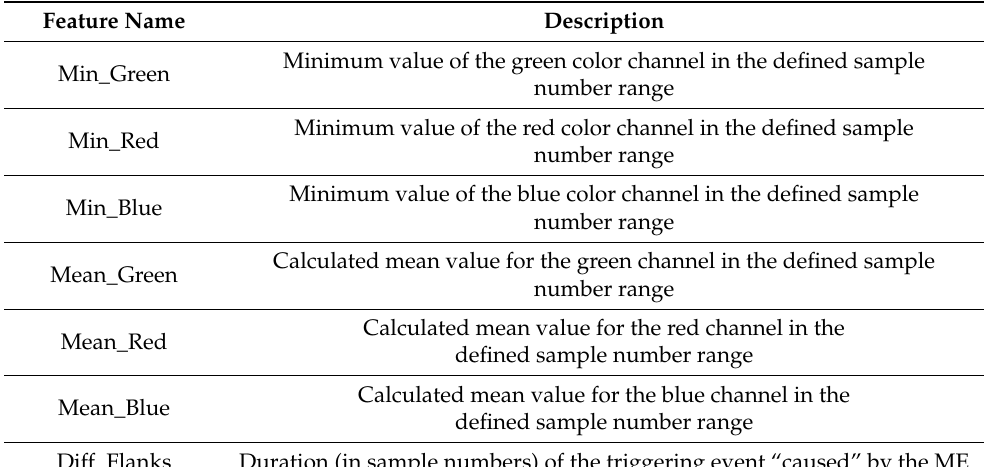
Table 5. Summary of the features used in the random forest model